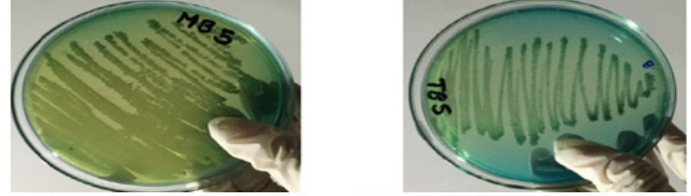
Fig. 2: PHP7 and PKD5 isolates showing dye degradation on Toulidine blue and Methylene blue on agar plate